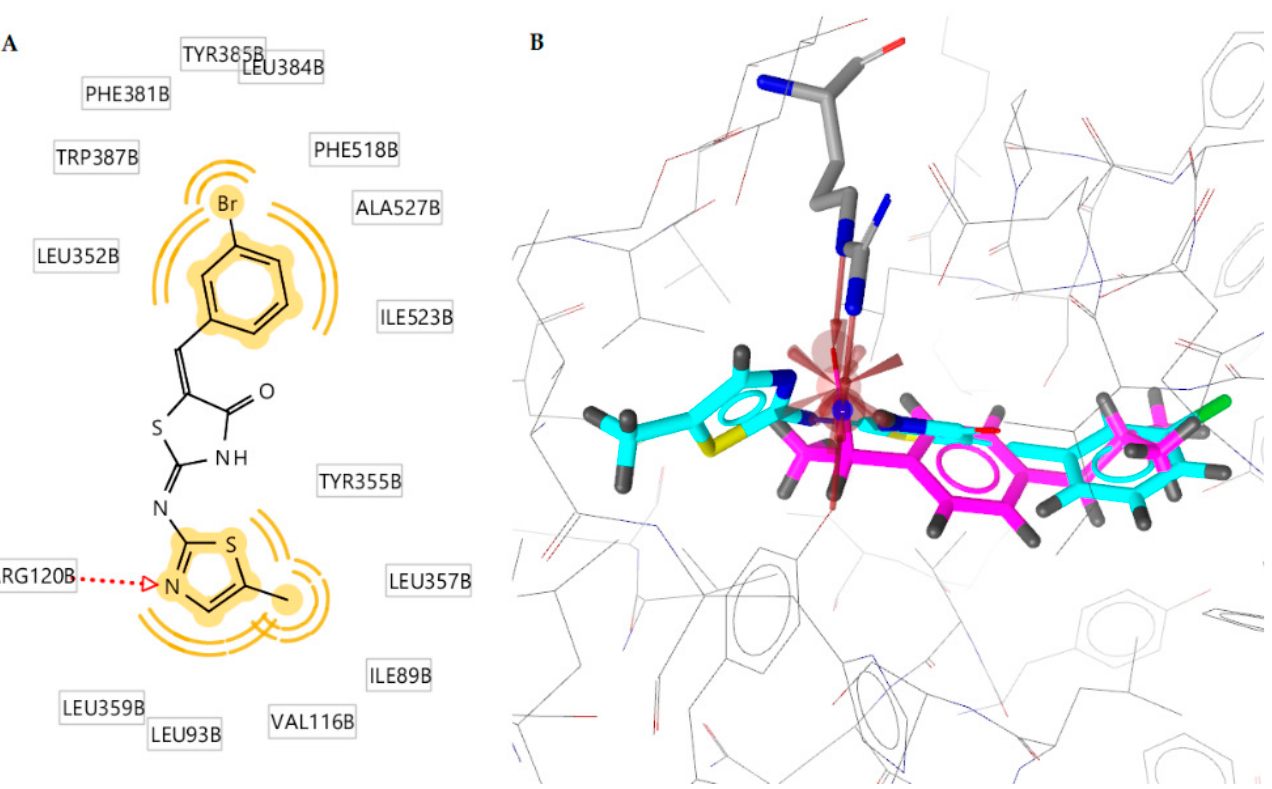
Figure 5. ( A ) 2D diagram of compound 16 in the binding pocket of COX-1. ( B ) Docked compound 16 (light blue) superimposed on the reference drug naproxen (magenta) in the active site of COX-1 enzyme. Red dotted arrows indicate H-bond and yellow spheres indicate hydrophobic interactions.